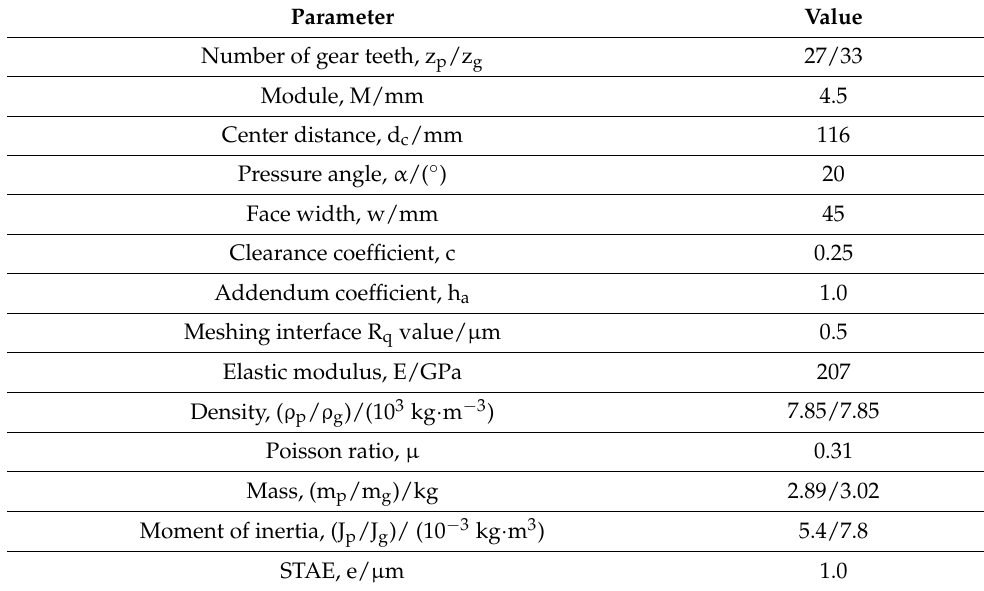
Table 2. Performance parameters of lubricating oil. Table 1. Basic design parameters of MGP.